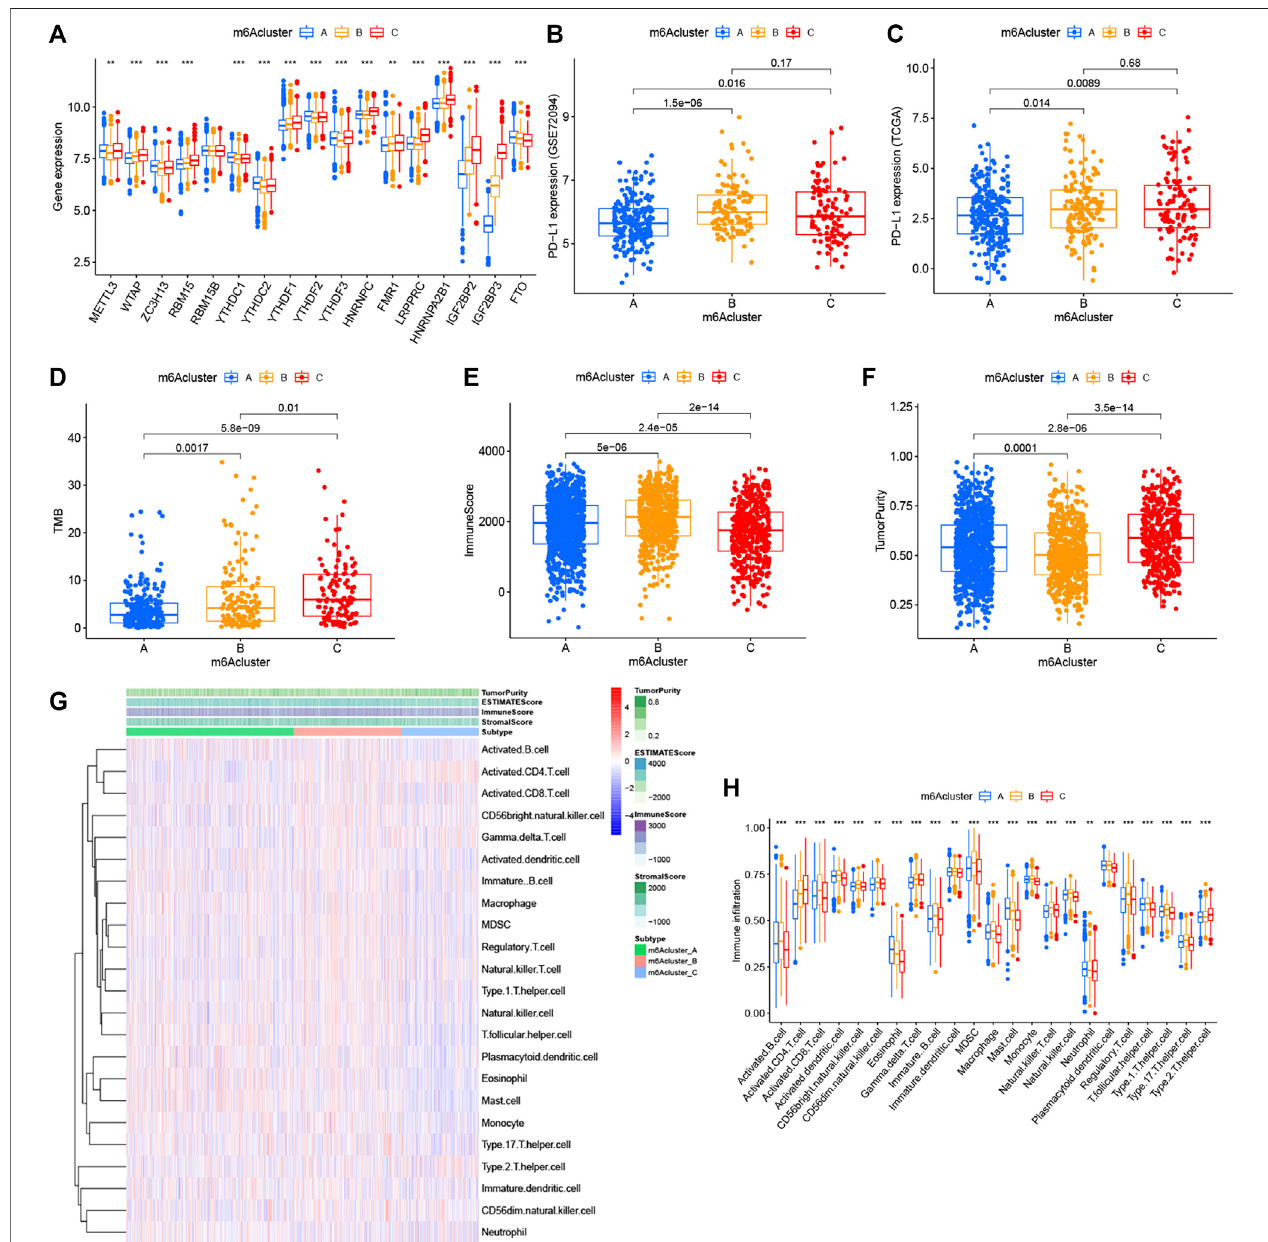
FIGURE3| Relationshipbetweenthethreem6Amodi fi cationpatternsandexpressionofm6AregulatorsandTMElandscape. (A) Expressiondifferenceof17m6A regulatorsinthethreem6Amodi fi cationpatterns.m6Acluster-A,blue;m6Acluster-B,yellow;m6Acluster-C,red.Thetopandbottomoftheboxrepresentedtherangeof quartilesofvalues.Thelinesintheboxesrepresentedmedianvalues,andthesoliddotsrepresentedoutliers.Theasteriskindicatedthestatistical p value(* p < 0.05;** p < 0.01;*** p < 0.001). (B) ExpressiondifferenceofPD-L1(CD274)inthethreem6Amodi fi cationpatternsintheGSE72094cohort. (C) ExpressiondifferenceofPD-L1 (CD274)inthethreem6Amodi fi cation patternsinTCGAcohort. (D) DifferenceofTMBinthethreem6Amodi fi cationpatternsinTCGA – LUADcohort. (E) Comparisonof immune scores across the three m6A modi fi cation patterns. (F) Comparison of tumor purity across the three m6A patterns. (G) TME landscape of the three m6A modi fi cation patterns. Tumor purity, immune score, ESTIMATE score, stroma score, and m6A clustering were noted above. Red indicated a high degree ofin fi ltration of TMEin fi ltratingcells,andblueindicatedalowdegreeofin fi ltrationofTMEin fi ltratingcells. (H) AbundanceofeachTMEin fi ltratingcellinthethreem6Adecorationmodes. The upper and lower ends of the box represented the quartile range of values. The lines in the box represented intermediate values, and the real points represented outliers. The asterisk represented the statistical p value. (*** p < 0.001; ** p < 0.01; * p < 0.05). m6Acluster-A, blue; m6Acluster-B, yellow; m6Acluster-C, red. For comparisons of the three groups, the Kruskal – Wallis test was